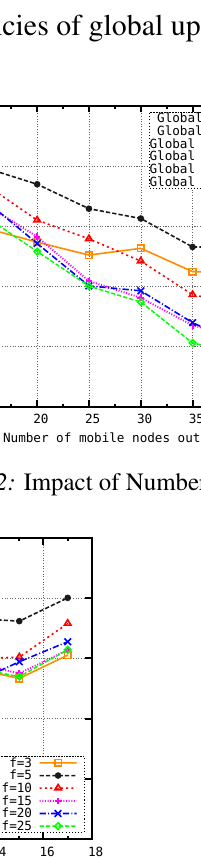
Figure 11. Execution Ratio for different frequencies of global